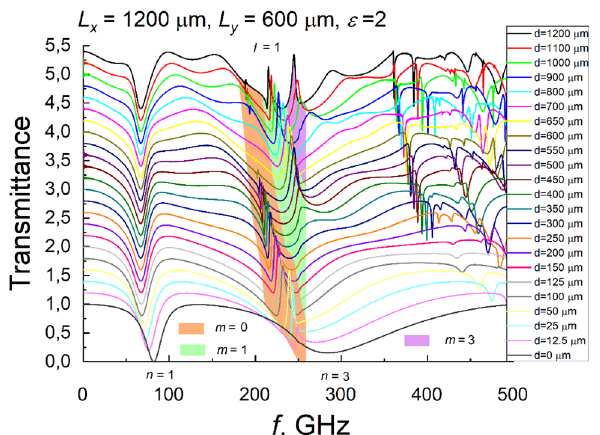
Figure 3. Calculated transmittance spectra of metamaterial composed of a mirrored array of split-ring resonators on a different thickness of the substrate (ε = 2). Substrate thickness is denoted in the figure. For the sake of clarity, spectra are shifted in the ordinate axis. Letter n marks plasmonic mode number, different colors correspond to different waveguide mode numbers, and letter l stands for the diffraction order.